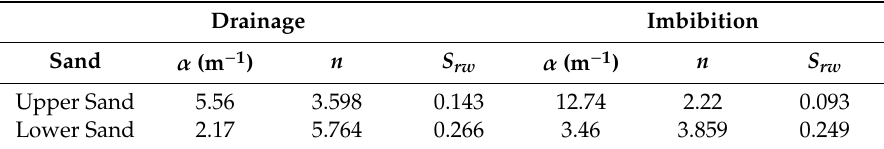
Table 2. Best-fit van Genuchten (1980) parameters.